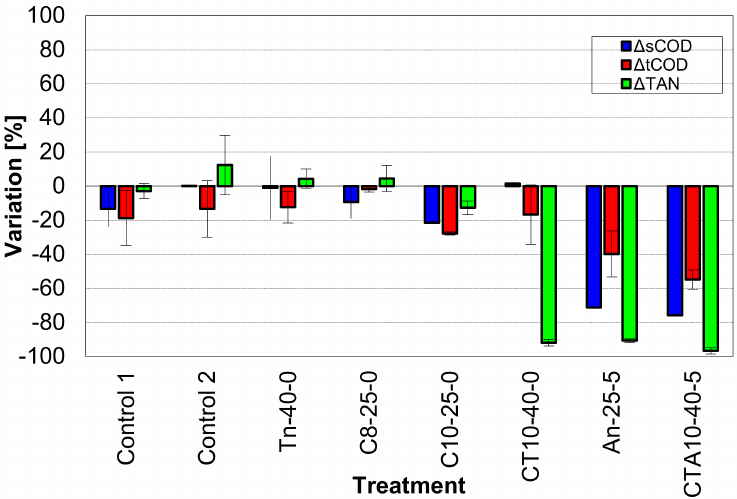
Figure 2. Variation of sCOD, tCOD, and TAN concentrations compared to the raw swine wastewater (SW) used at the end of the treatment. TAN = Total ammonia nitrogen; sCOD and tCOD = soluble and total COD; ∆ sCOD, ∆ tCOD, and ∆ TAN = variations of sCOD, tCOD, and TAN throughout the treatment; the capital letters of the tests indicate the treatment, and the three letters / numbers identify the value of the operational parameter, pH, temperature, and air flow rate; C = chemical; T = thermal; A = aerated; and c = control. The error bars represent the standard deviations. The experiments were carried out in